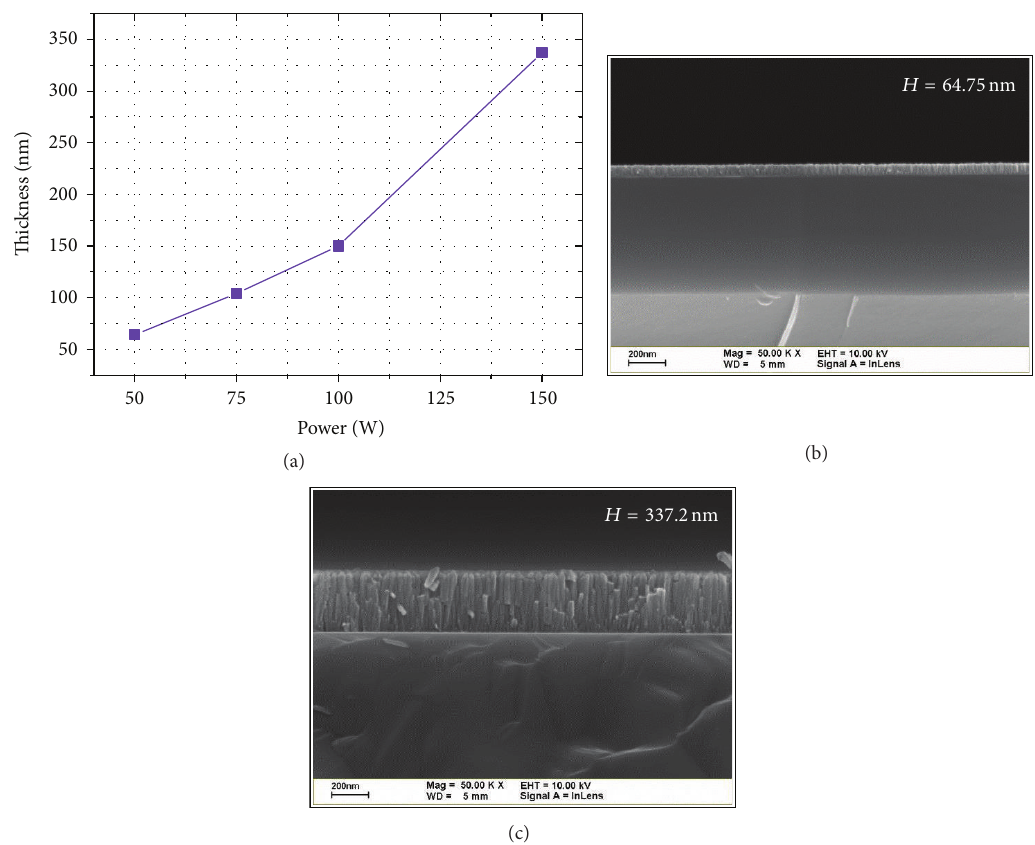
Figure 3: (a) The thickness values as a function of the ZnO thin films with different RF powers ranged from 50 to 150W. (b) and (c) are the cross-sectional micrographs for the ZnO thin films deposited at the RF powers of 50 and 150 W,